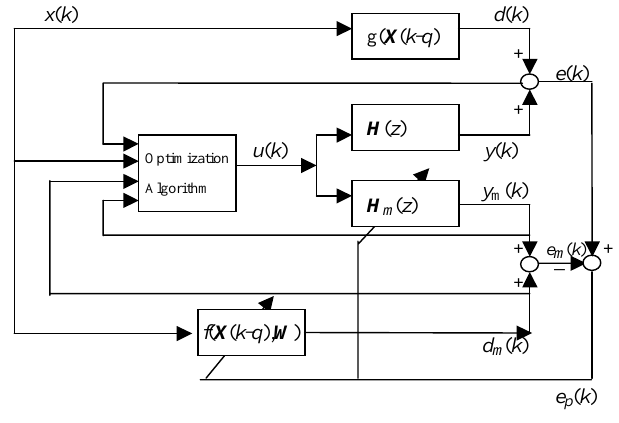
Fig. 4. Block diagram of adaptive ANC system with online secondary path